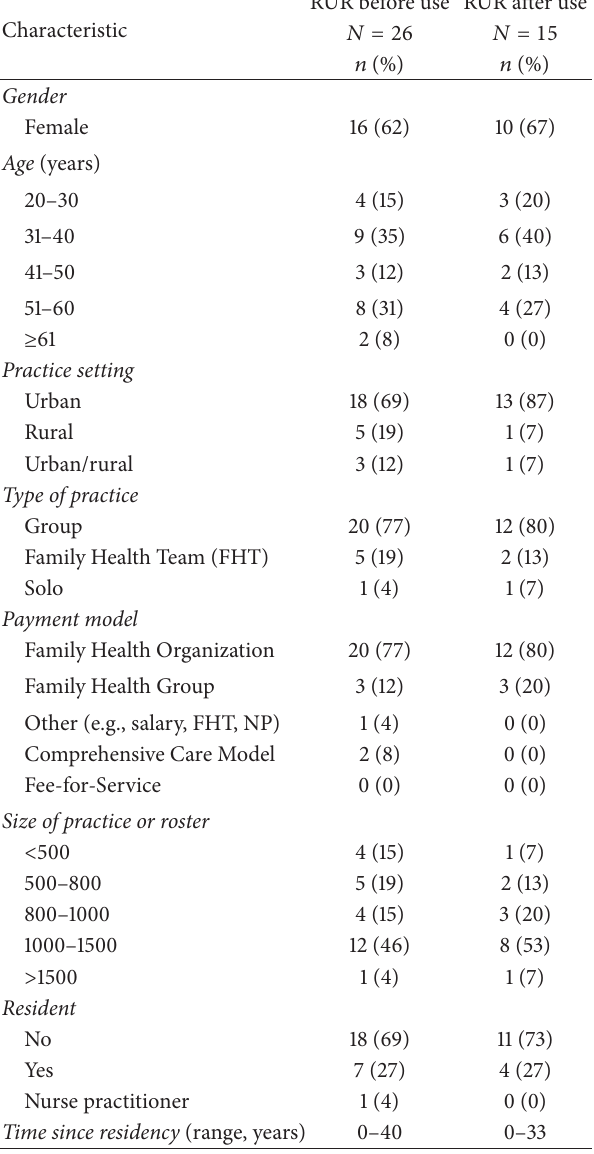
Table 1: Characteristics of study